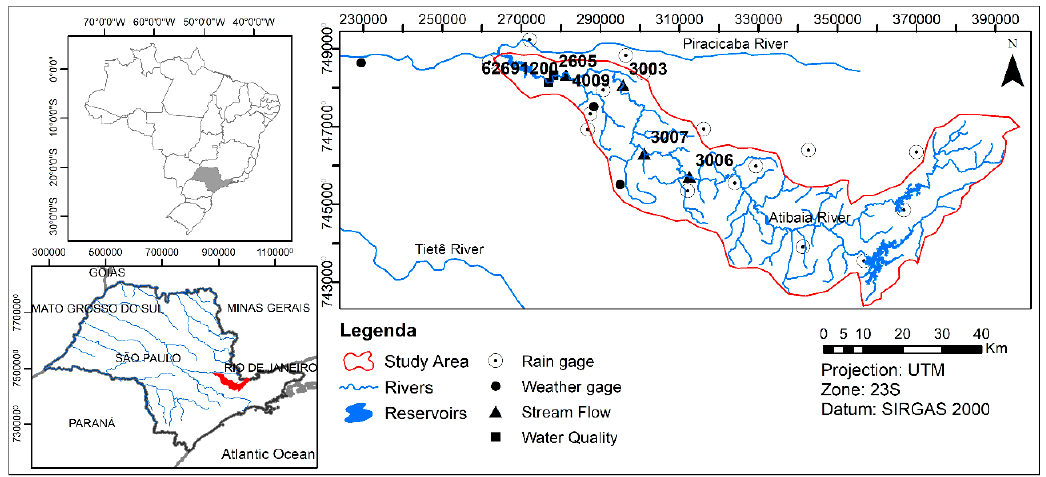
Figure 1. Study area location with the rain, weather and hydrometric gages.